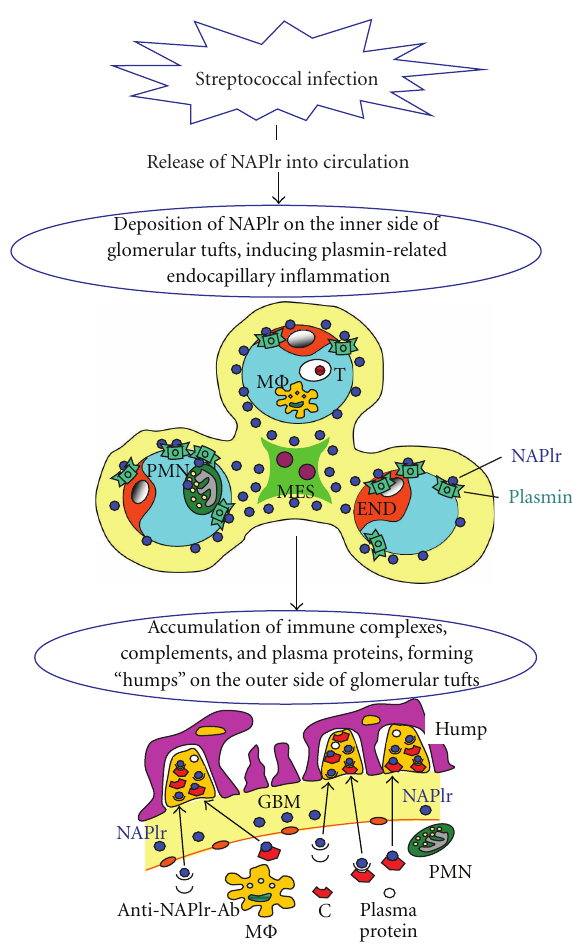
Figure 7: Schematic representation of proposed mechanisms in- volved in the development of APSGN. MES: mesangial cell; END: endothelial cell; PMN: polymorphonuclear cell; M Φ : macrophage; T: T lymphocyte; GBM: glomerular basement membrane; C: com- plement; Anti-NAPlr-Ab: